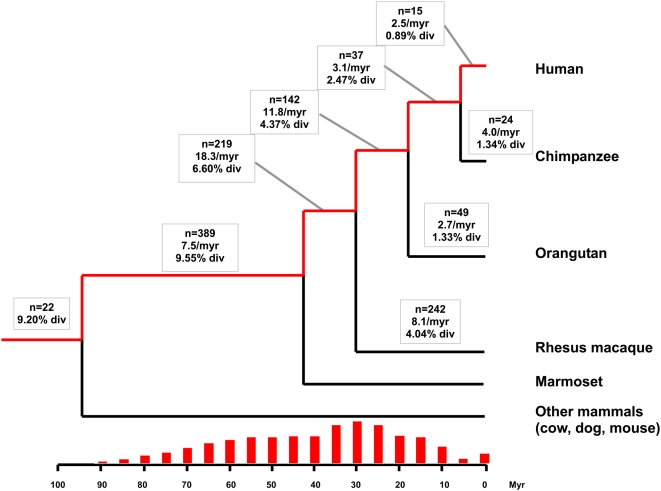
Rate and timing of RD formation.For each branch, the number of RDs created (n), the rate of repair-mediated duplication (per myr), and the average divergence of acceptor and donor pairs (%) during the time period are shown. The timing of RD formation for the human lineage (indicated by the red branches) is shown above the time scale by the red vertical bars. Each individual bar shows the relative proportion of RDs falling within the same, non-overlapping 5-myr bin.